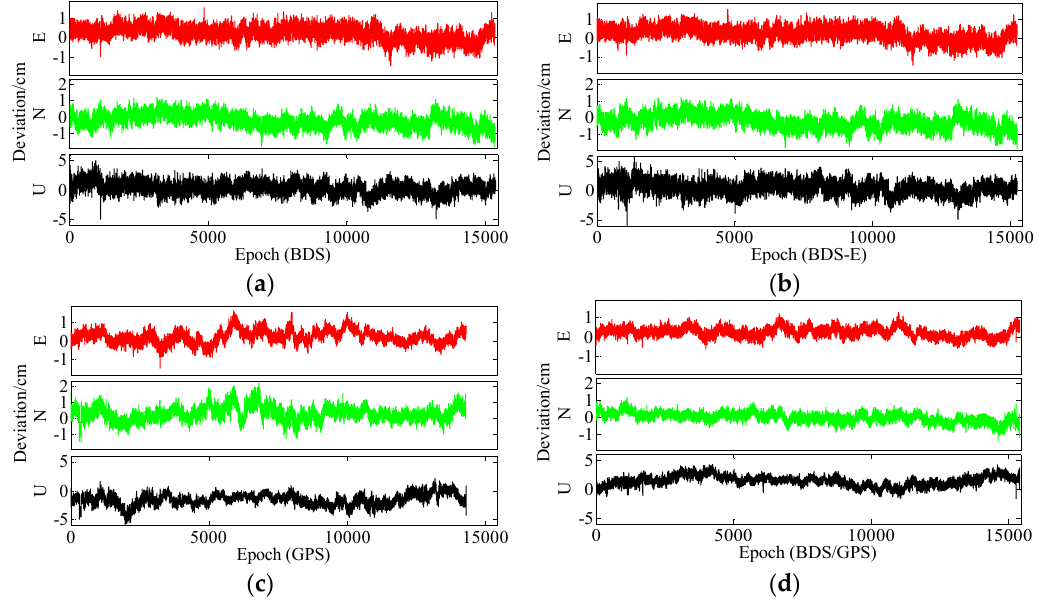
Figure 24. ENU deviations of four systems. ( a ) ENU deviations of BDS. ( b ) ENU deviations of BDS-E. ( c ) ENU deviations of GPS. ( d ) ENU deviations of BDS/GPS.